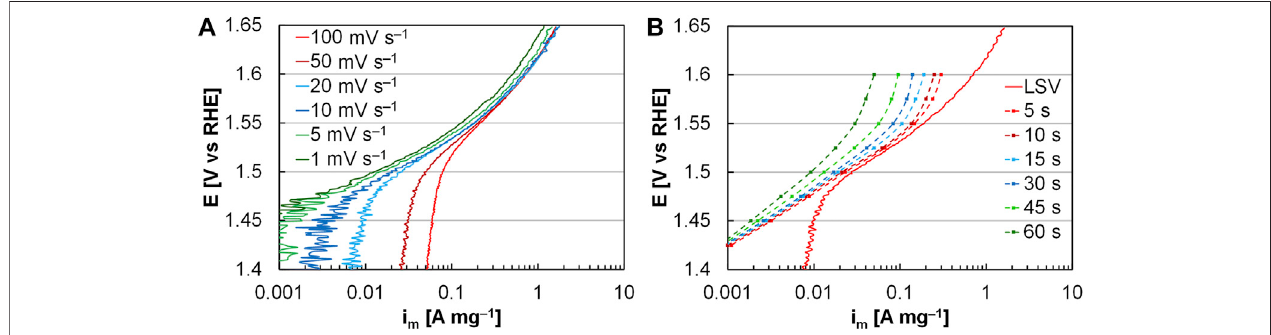
FIGURE 3 | (A) Linear sweep voltammograms at varying scan rates. (B) Successive chronoamperometry tests, varied by duration, compared to a linear sweep voltammogram at 20 mV s − 1 . Electrodes were coated with AA iridium to a loading of 17.8 µg Ir cm − 2 (Alia and Anderson, 2019). © The Electrochemical Society. Reproduced by permission of IOP Publishing. All rights